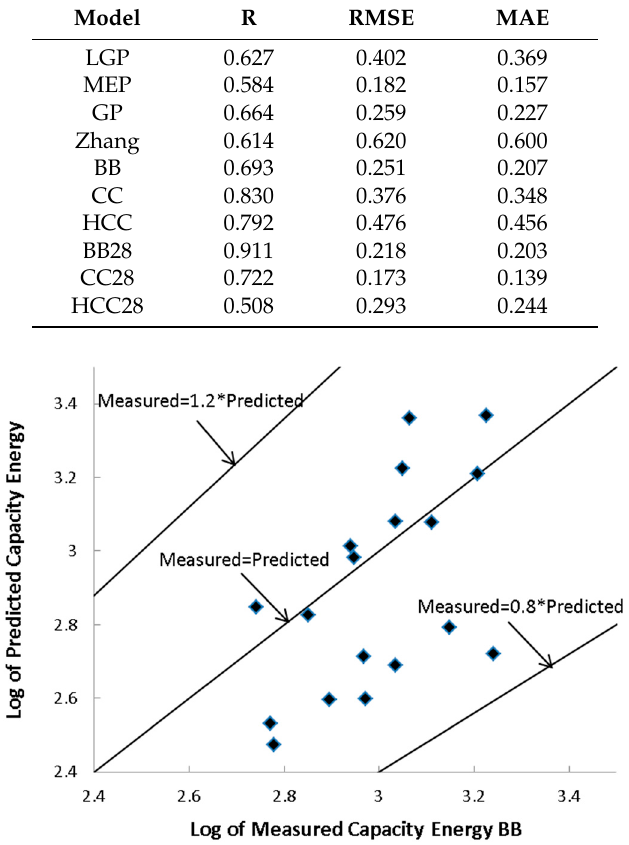
Figure 2. Capacity energy predicted by RSM equation on the basis of the Box-Behnken DOE and the first ANN model versus the measured values of laboratory tests.